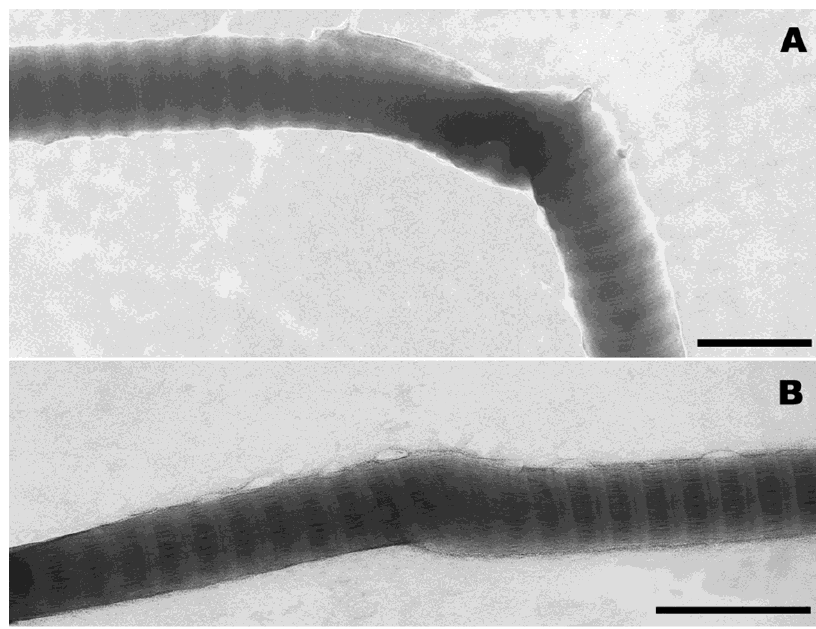
FIGURE 5 . (A) An isolated fibril from rat Achilles tendon observed at TEM. The fibril shows a knot comparable to a fibrillar crimp. In the fibrillar crimp region, the fibril twists to the left and then sharply bends. The periodic D-banding of about 67 nm appears less recognizable in the fibrillar crimp region. (B) An isolated fibril from rat medial collateral ligament observed at TEM shows a straightened fibrillar crimp. In the fibrillar crimp region, the periodic D-banding appears less regular and a microfibrillar swelling is partially evident. Bar = 200